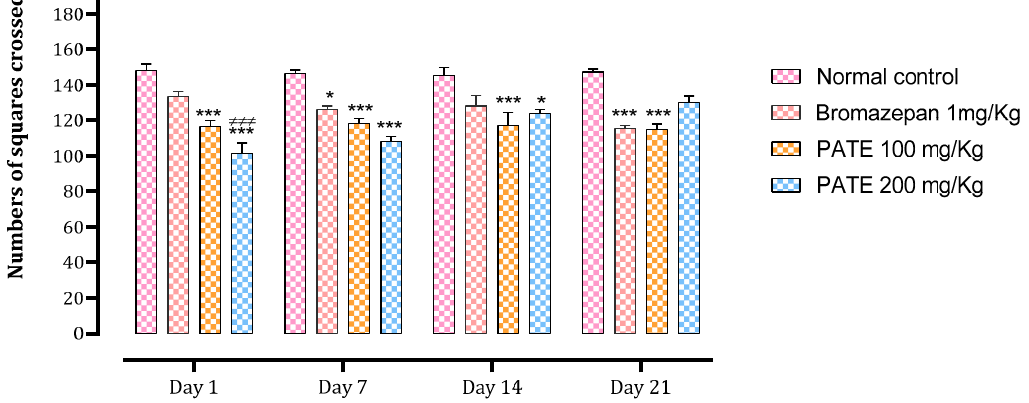
Figure 5. Effect of PATE on the variation in the number of tiles traversed during OFT in mice. Data are represented as mean ± SEM. (* p ≤ 0.05, *** p ≤ 0.001 compared to the negative control. ≠≠≠ p ≤ 0.001 compared to the positive control).